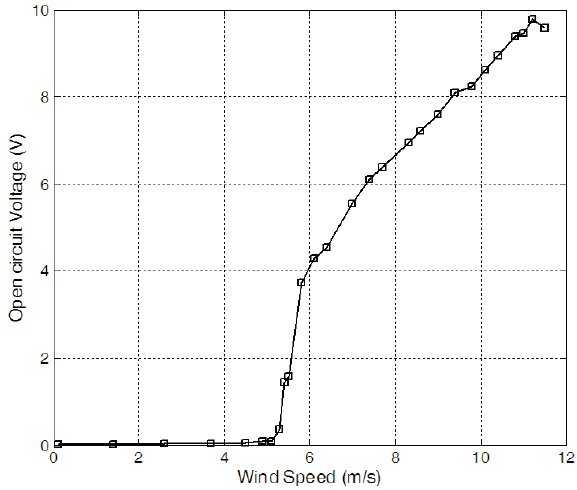
Figure 3. Open circuit voltage versus wind speed.